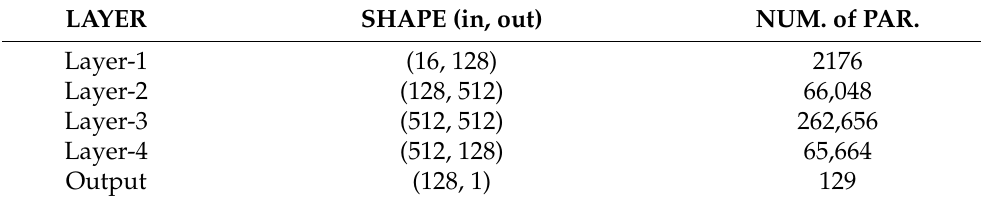
Table A2. Model Architecture for the regression model for continuous data (simulated as in Equa- tion (3)) used in the test for the dependence of model performance on data domain for different linearity factors ( α ) (Figure 3, left panel). Mean Squared Error (MSE) was used for the loss estimation. Stochastic Gradient Descent (SGD) with learning rate = 0.005 was used as the optimizer.